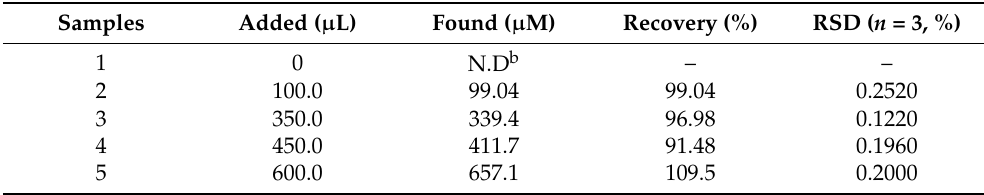
Table 3. Detection of FA in the actual